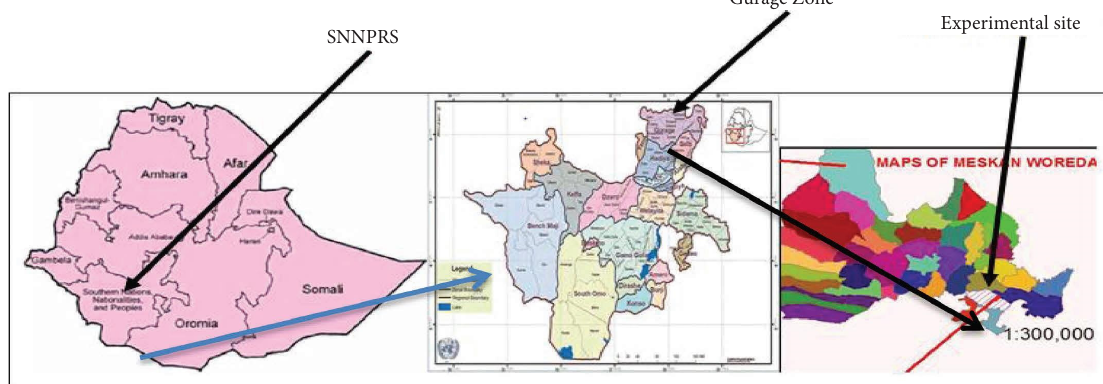
Figure 1: Map of the experimental site in Meskan District, Gurage Zone, Southern